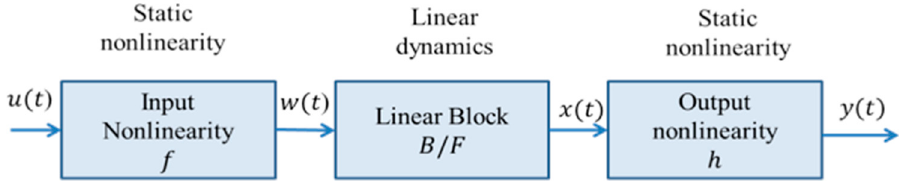
Figure 3. Block diagram of the H-W model consisting of a linear dynamic block cascaded between two static nonlinear blocks.